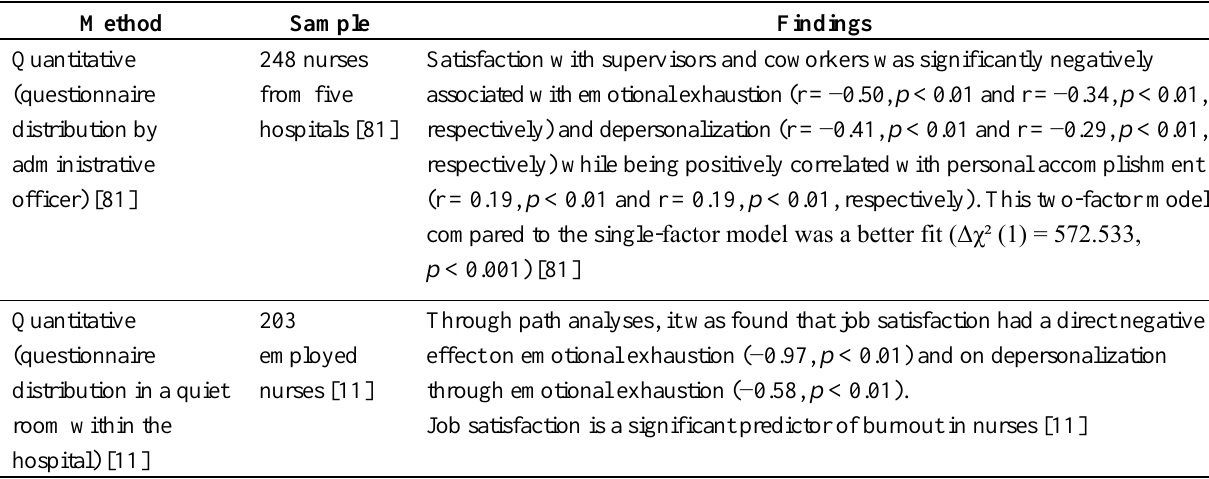
Table 7. Method, sample and findings of identified articles.